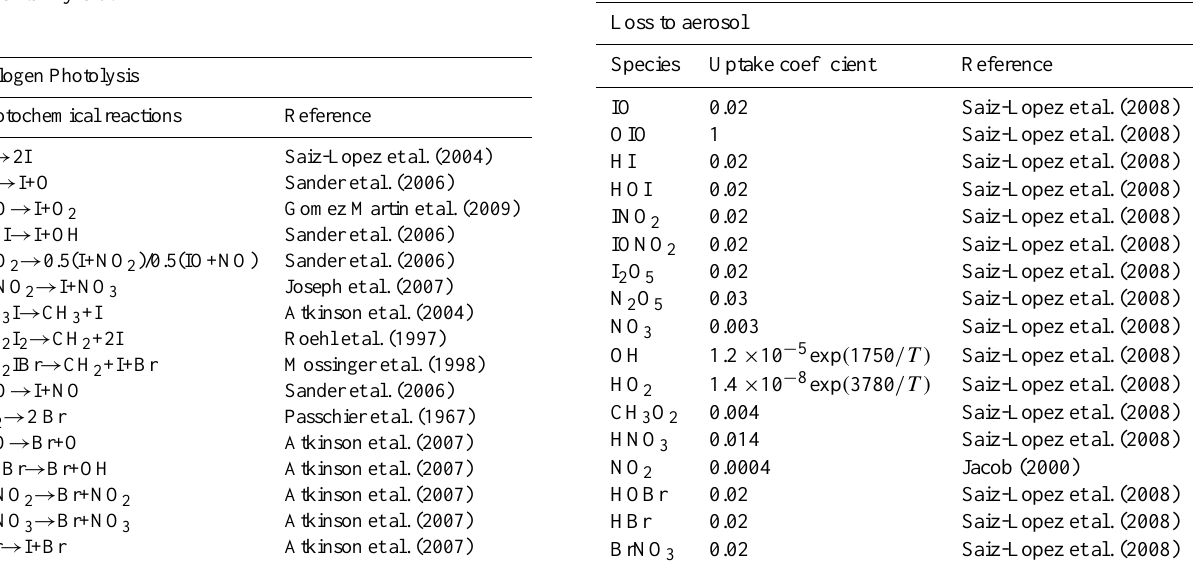
Table A5. Halogen chemistry reaction scheme – loss to